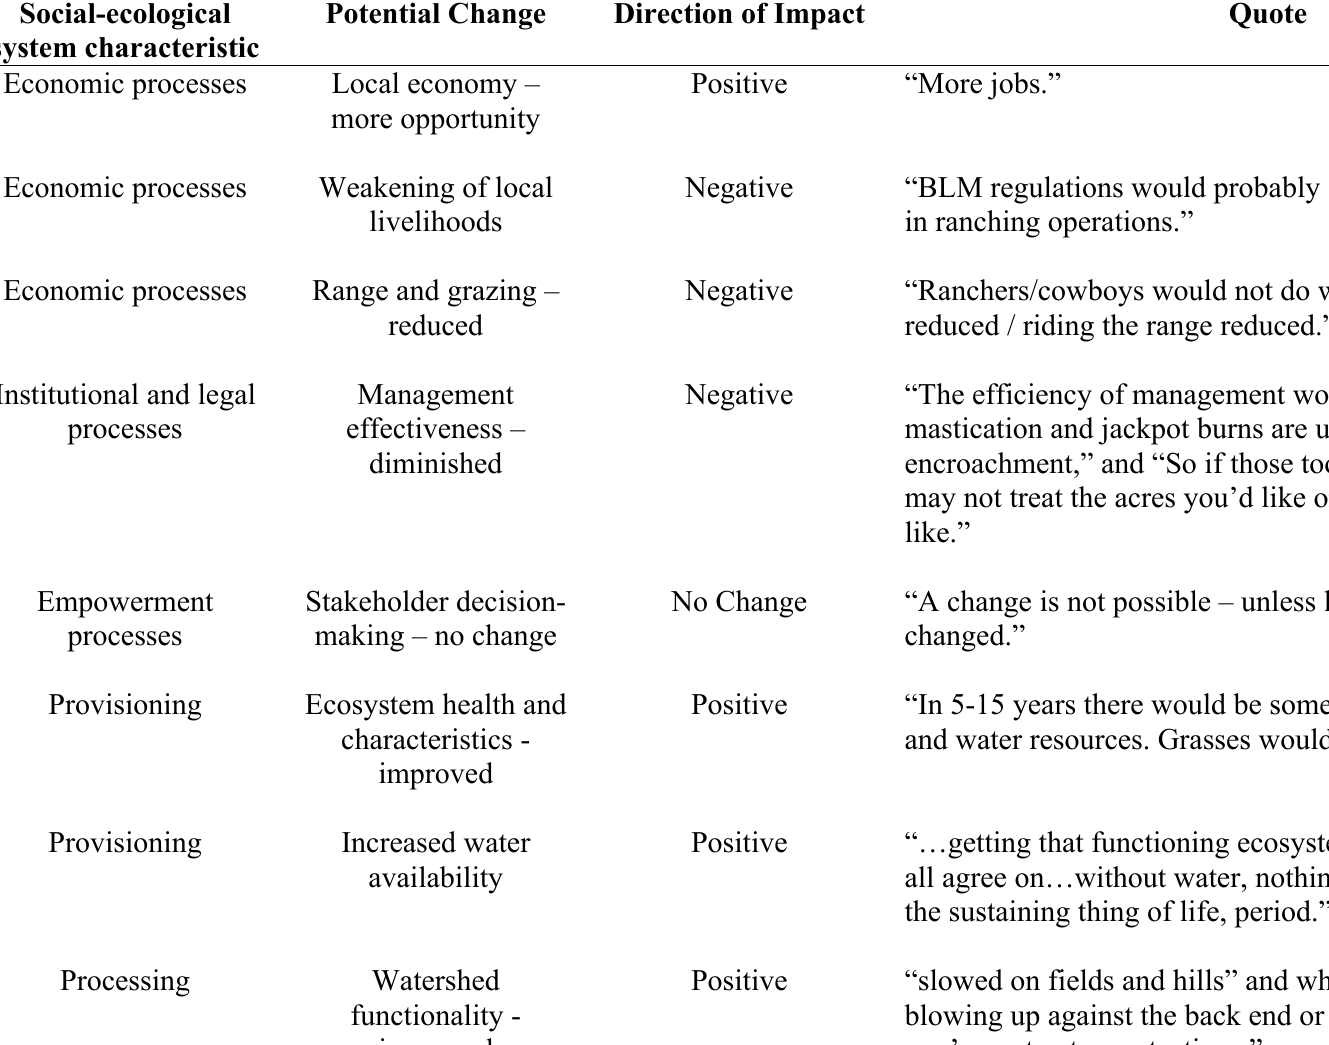
Table 3. Workshop participants’ responses to the cut and scatter